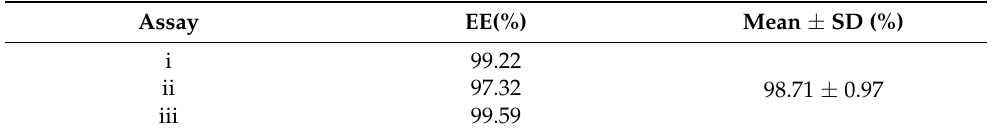
Table 6. Doxorubicin encapsulation efficiency, EE(%), in DOPE:Ch:CHEMS (45:45:10) SMLs con- taining Mg 0.75 Ca 0.25 Fe 2 O 4 nanoparticles from three independent measurements (i, ii and iii) and re-